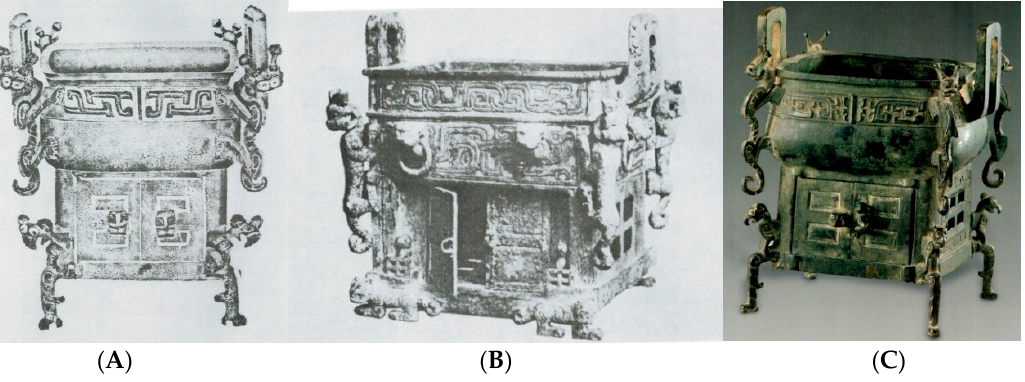
Figure 3. Three examples of the fangding ( yiding , also called fangli ) of late Western Zhou date: ( A , B ) Li Zhen fangli 季真方鬲 and ( B ) Animal-footed fangli . Reproduced from Shang Zhou Yiqi Tongkao, xia: 97–98; ( C ) Human guarding gate fangding . Reproduced from (Zhouyuan 2016) : color plate 64. Further comparisons indicate that these whimsical versions of tetrapod belong to the category of rectangular ding or fangding that are four-sided and four-legged. The inscription of the third bronze, excavated from the Zhuangbai cache in Zhouyuan, Shaanxi, is self-inscribed with the hewen , transcribed 鎘 li ( 金 signifier + 鬲 sound/ 鎘 ). Li 鎘 [ ] and ding 鼎 words are based on the ding vessel